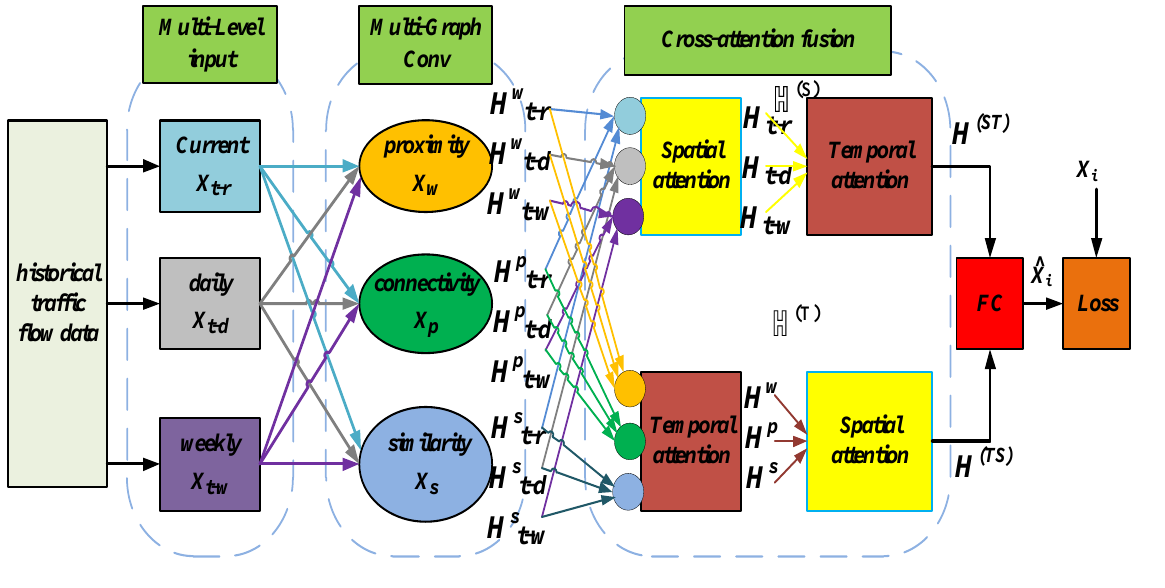
Figure 3. CAFMGCN framework.